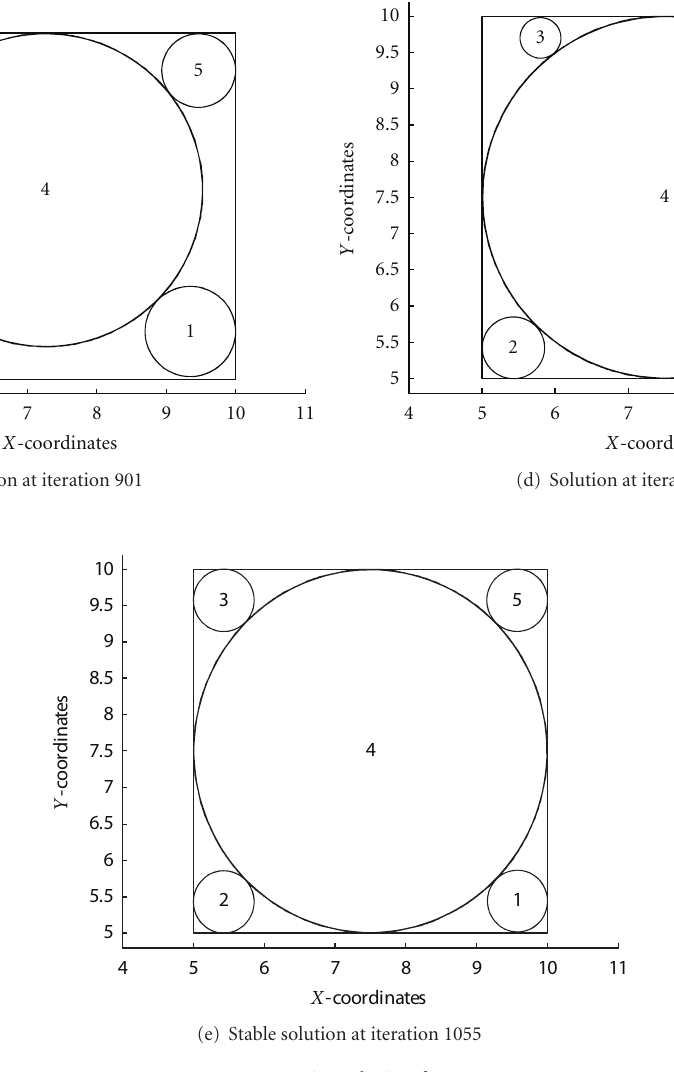
Figure 3: Stepwise solution for Case